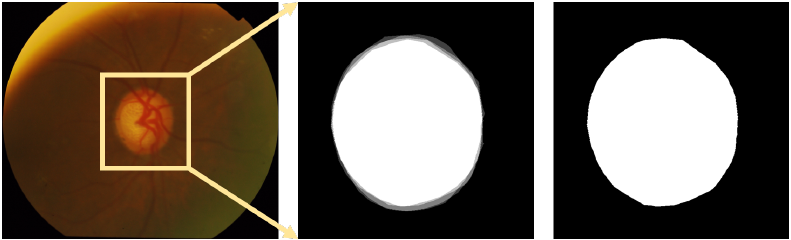
Figure 19. An example of the DRSHTI-GS dataset. (left to right) Original fundus image, GT soft map, and the GT used in this paper (In a soft map, the pixel value of each annotation is 0.25. The part with a pixel value greater than or equal to 0.75 was used as the